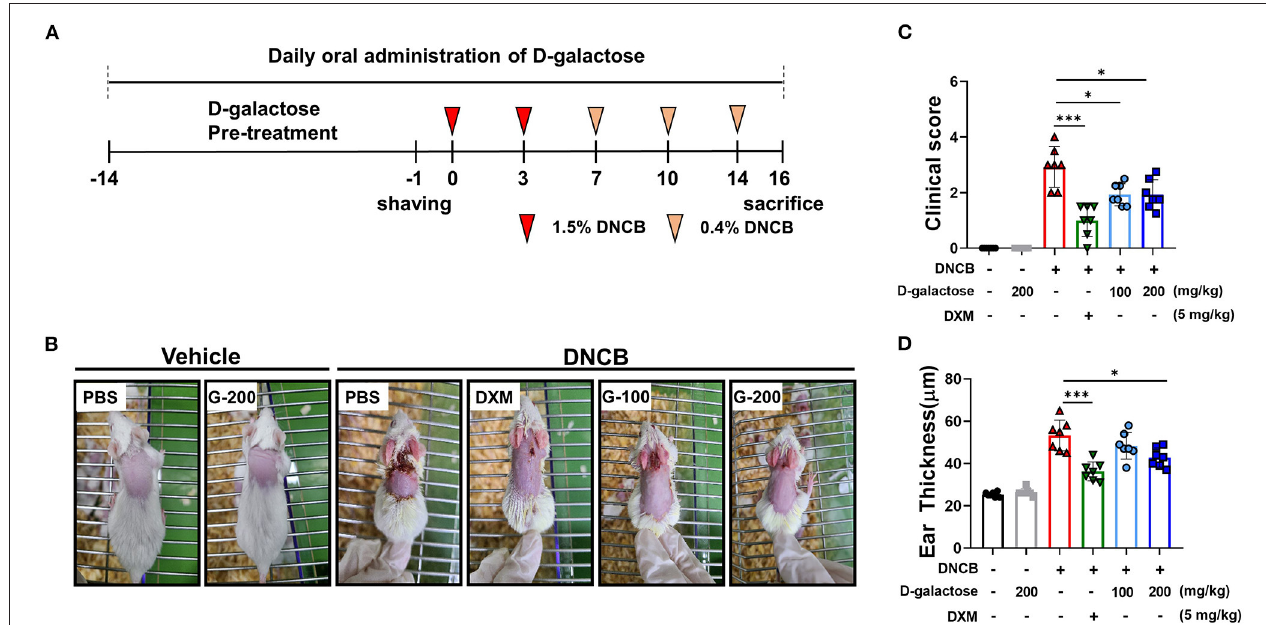
FIGURE 1 | Protective effects of D-galactose on DNCB-induced atopic dermatitis in mice. (A) Schematic diagram showing the experimental design of DNCB-induced AD mouse model. Mice were divided to six groups ( n = 7/group). (B) AD-like skin lesions were evaluated by visual observation. (C) The dermatitis index was scored as described in the materials and methods. (D) Ear thickness was measured before sacrificing. Values are means ± SD. The significance of differences between the groups was assessed using Mann-Whitney U -test, with the level of significance set at * P < 0.05,** P < 0.01,*** P <